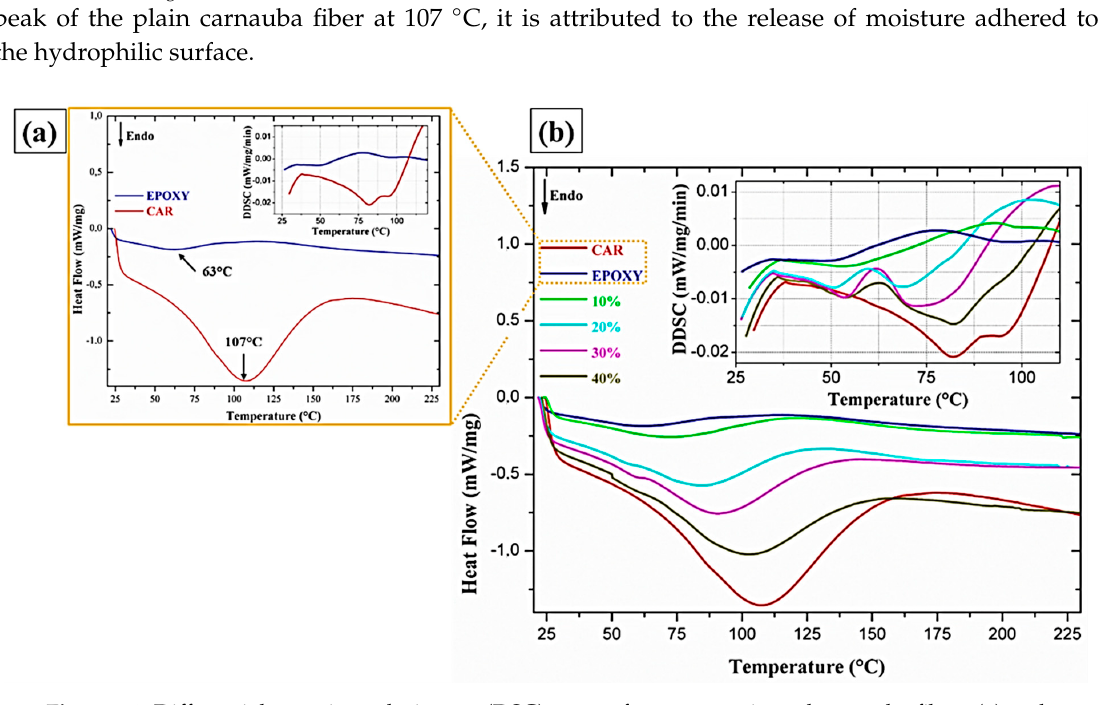
Table 7. Dynamic mechanical analysis (DMA) parameters.